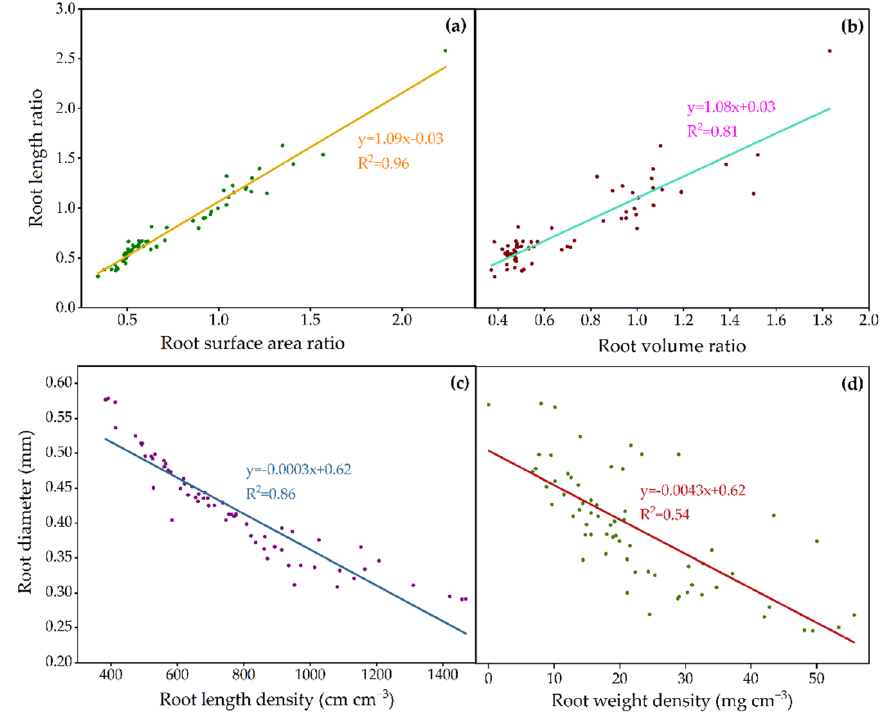
Figure 6. Linear fitting of root phenotypic characteristics: ( a ) root length ratio vs. root surface area ratio; ( b ) root length ratio vs. root volume ratio; ( c ) root diameter vs. root length density; ( d ) root diameter vs. root weight density.